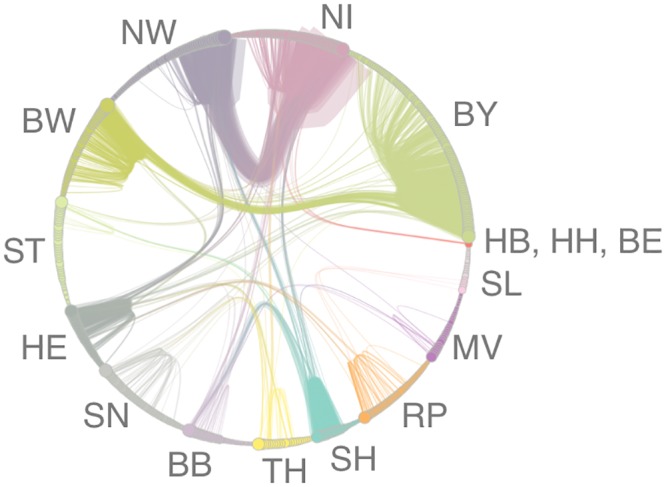
Trade between districts in Germany.Node sizes correspond to the degree. Edges are bundled with respect to the federal states. Trade is dominated by links between districts in NW and NI and BY and BW, respectively. Self-loops (intra-state trade) are not shown.